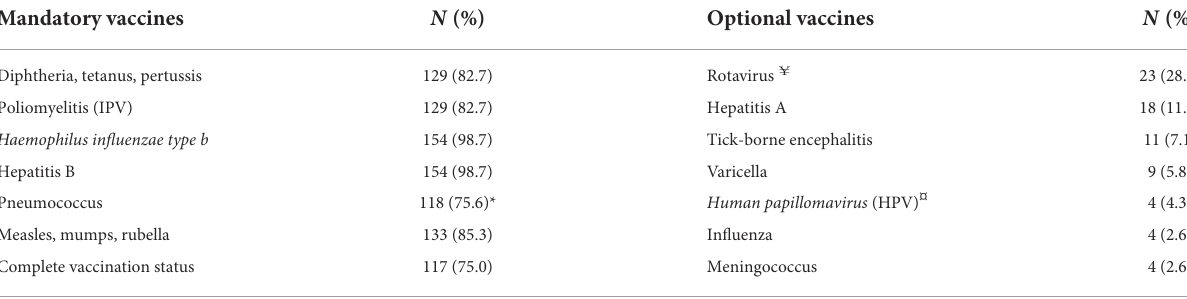
TABLE 4 Coverage rates for mandatory and optional vaccines at the reference